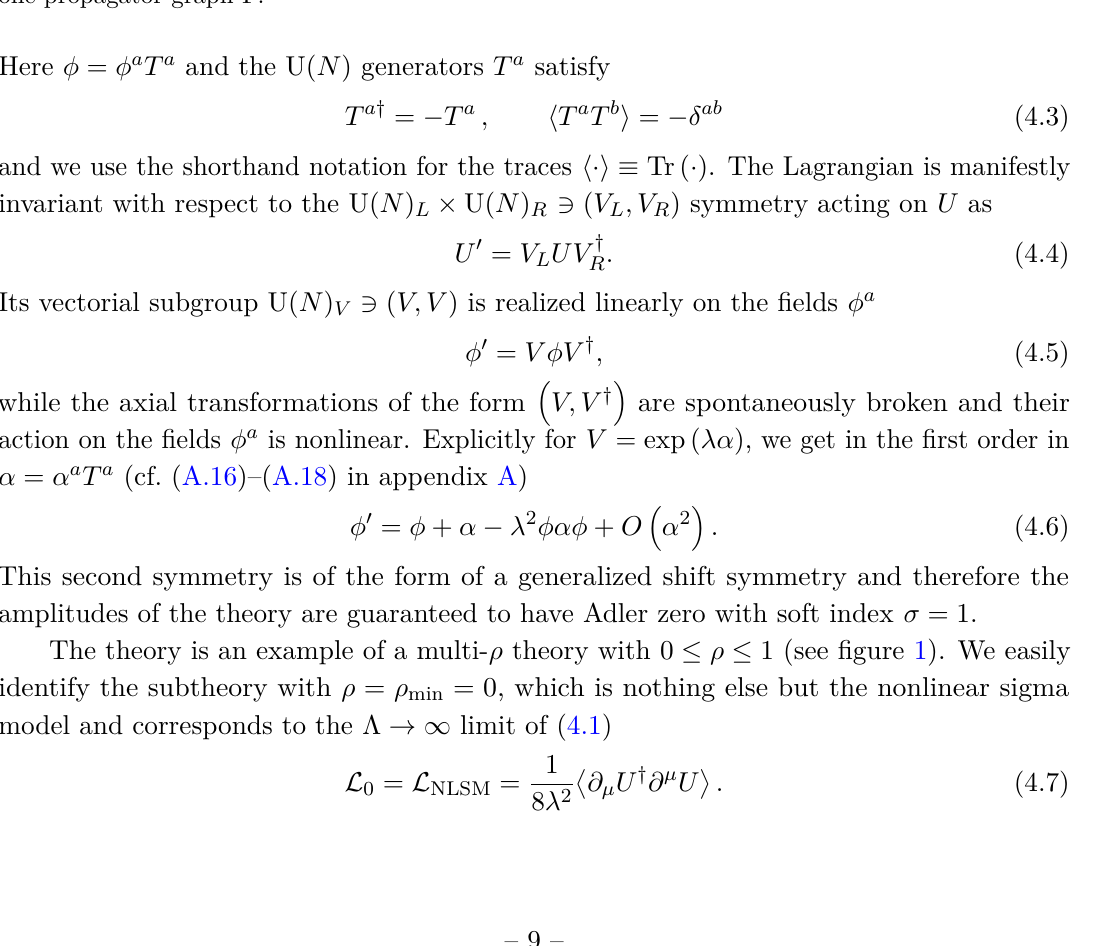
Figure 1 . Graphical representation of the model with Lagrangian (4.1) in the ( N − 2 , D − 2) plane. The points represent both the various vertices of the Lagrangian as well as the various contributions to the scattering amplitudes. For illustration of the general discussion in section 2, we have depicted one particular point P corresponding to A (1 / 2) and two vertices which can contribute to it via Γ 10 one-propagator graph Γ